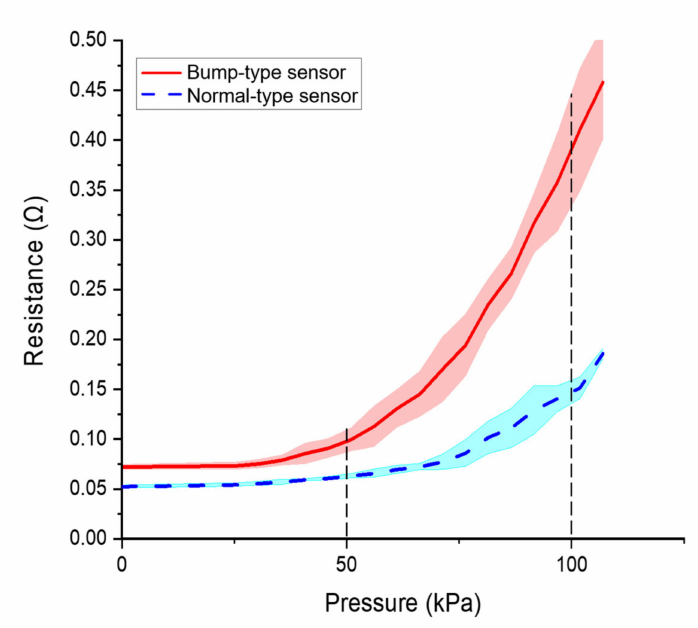
Figure 16. Variation of resistance with applied pressure in normal- and bump-type sensors. Table 8. Comparison of sensor responsivity.